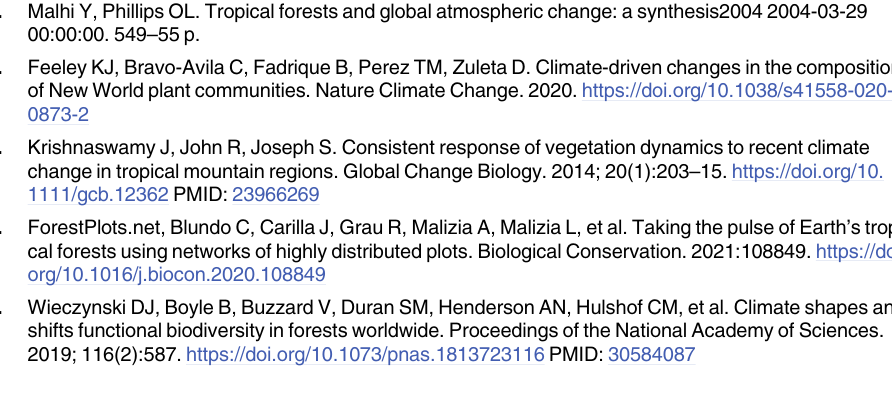
showing the slope positions and their respective Topographic Position Index values (TPI), from most negative values at valley bottoms to most positive values at ridge tops. (DOCX) S5 Fig. Correlations of soil features with Topographic Position Index (TPI) in the 18 study plots. Soil properties: Depth of organic layer (dol), pH value, concentrations of K, Mg, Ca, Al and N, C:N ratio, plant available phosphorus (Pav), nitrogen mineralization rate (Nmin) and nitrogen nitrification rate (Nnitr). Data from Wolf et al . (2011) as presented in Pierick et al. (2021). All correlations are statistically significant, and shadows indicate 95% confidence inter- vals.